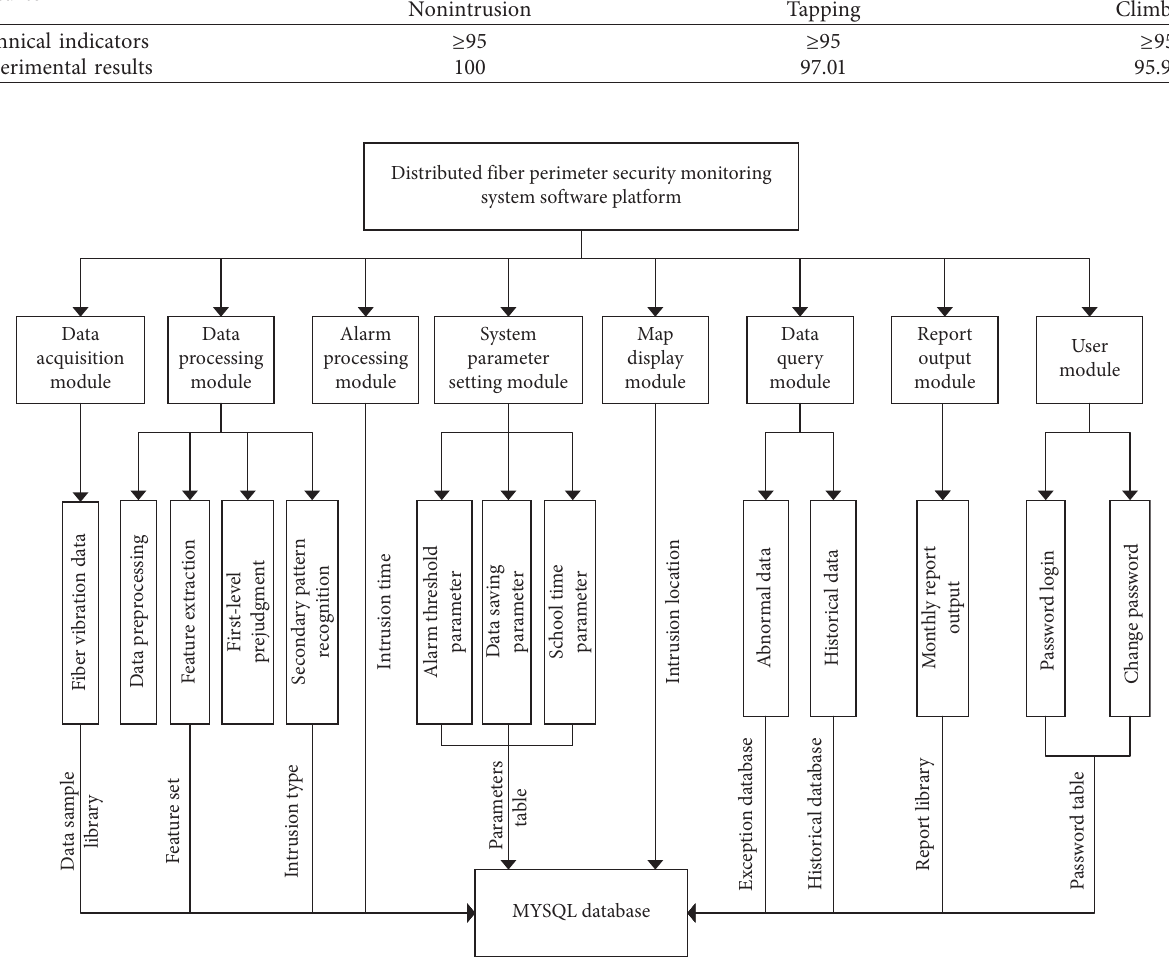
Figure 11: Software block diagram of the distributed fiber perimeter security monitoring system.